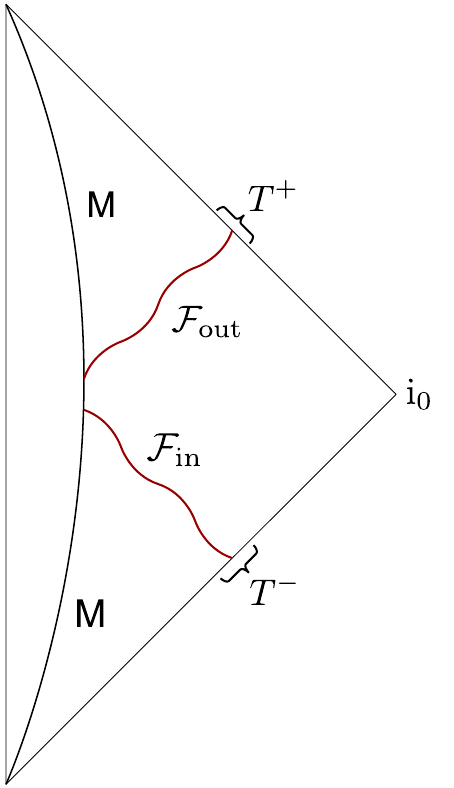
Fig. 2 A Goldstone supertranslation on a generic system of mass M . Radiation with angular distribution F in scatters so that radiation with angular distribution F out is returned. Since d u d 2 (cid:4) F out , the total energy of the system remains unchanged. Here